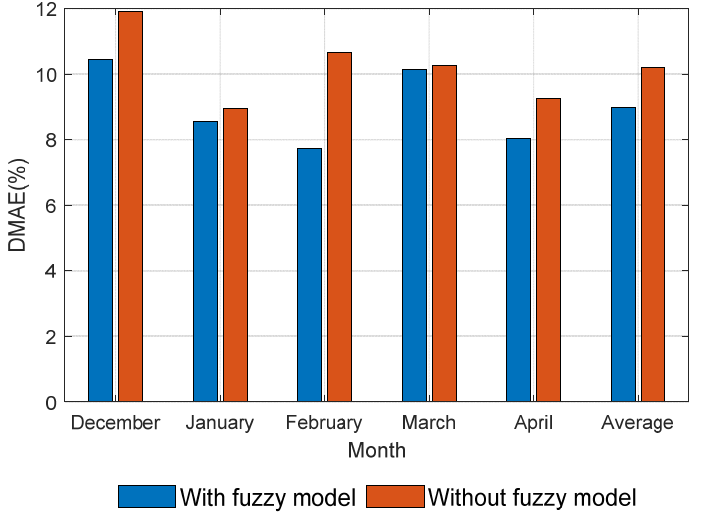
Figure 9. Estimation results with and without fuzzy